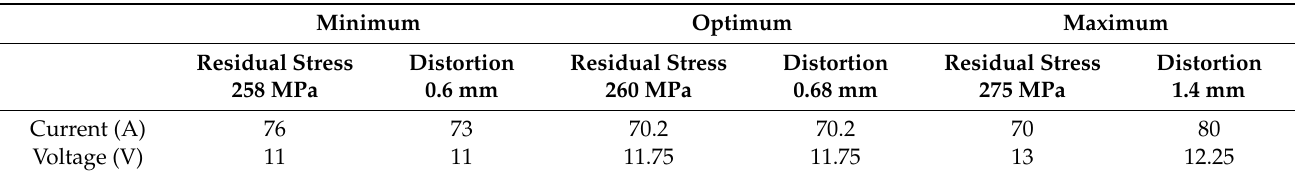
Figure 14. The validation of the distortion results at the optimum point. In Table 5, the minimum, maximum, and optimum values of both quantities (i.e., distortion and residual stress) are shown. Table 5. A summary of the results.